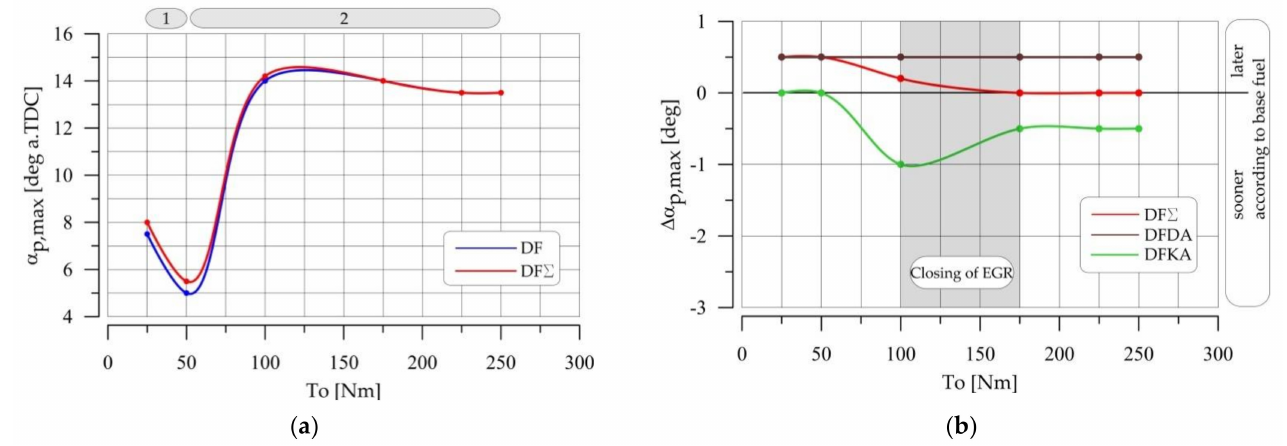
Figure 21. ( a ) Occurrence of the maximum pressure in the cylinder vs. engine torque, 1 = combustion range of very small fuel doses, 2 = combustion range of larger fuel doses); ( b ) Difference in the occurrence of the maximum pressure in the cylinder vs. engine torque in relation to the base